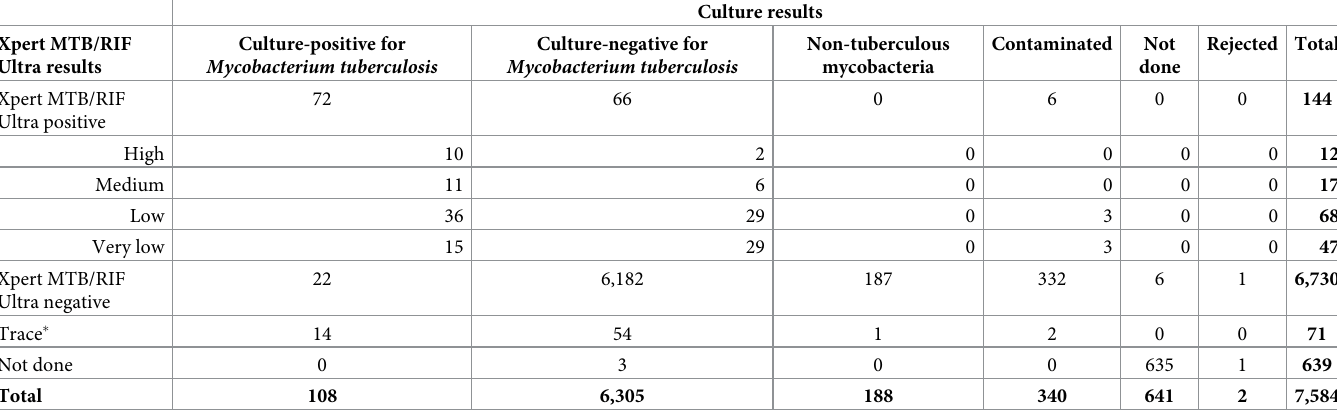
Table 2. Xpert MTB/RIF Ultra and MGIT culture results among those who screened